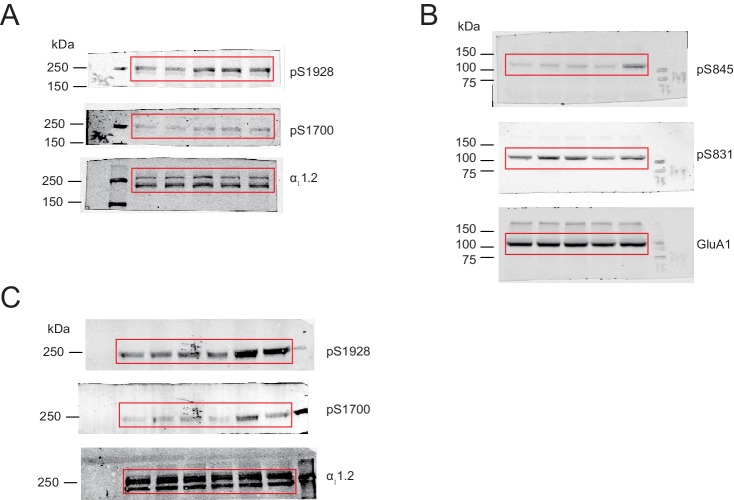
Uncropped blots for Figure 4.(A) Uncropped blots corresponding to Figure 4A. (B) Uncropped blots corresponding to Figure 4B. (C) Uncropped blots corresponding to Figure 4C. Red box indicates the crop region displayed in main figure.